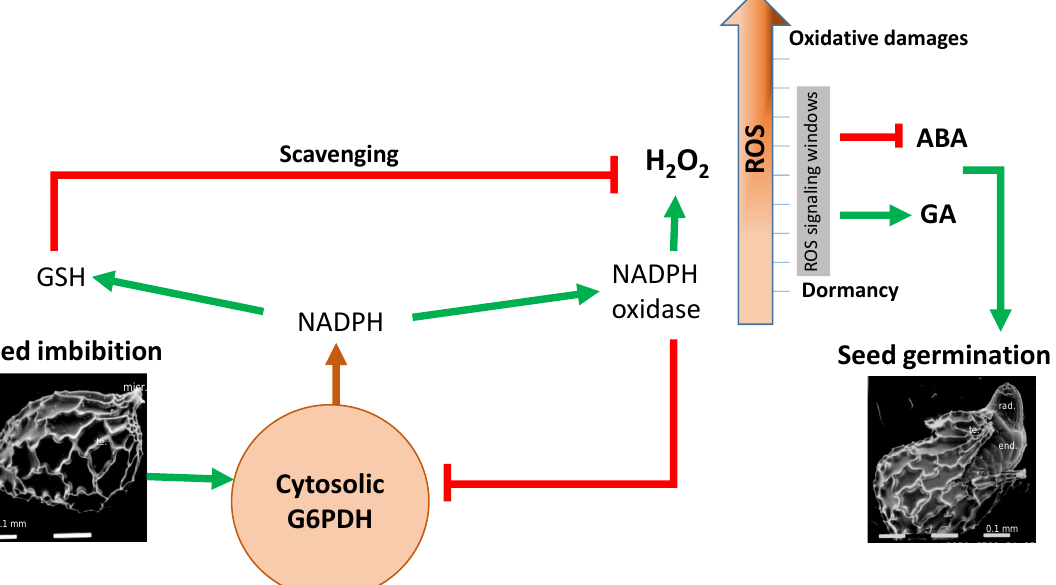
Figure 3. Cytosolic G6PDH in radicle of imbibed seed modulates ROS homeostasis and hormonal signaling in the control of seed germination. The NADPH provided by cytosolic G6PDH activity is required both for ROS production by NADPH oxidase and for ROS scavenging by activation of GSH ascorbate cycle; the working model based on genetic evidence proposed that G6PDH modulates ROS to a steady state level controlling ABA and GA activities and dormancy release; GSH, reduced glutathione; ROS, reactive oxygen species; ABA, abscisic acid; GA, gibberellic